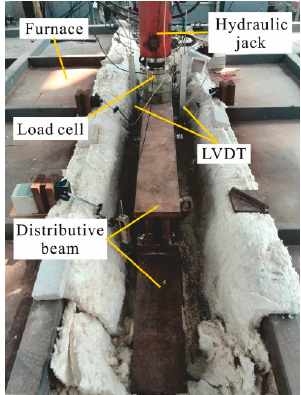
Figure 7. Photo of a specimen during the fire test.